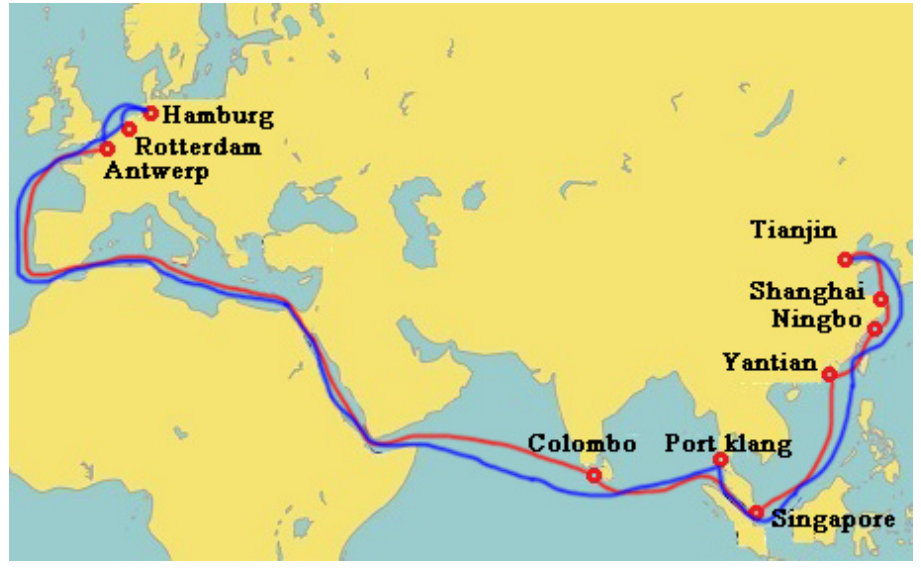
Figure 1. European route of this study. Table 6. Distance between berthing ports on this route. Unit: